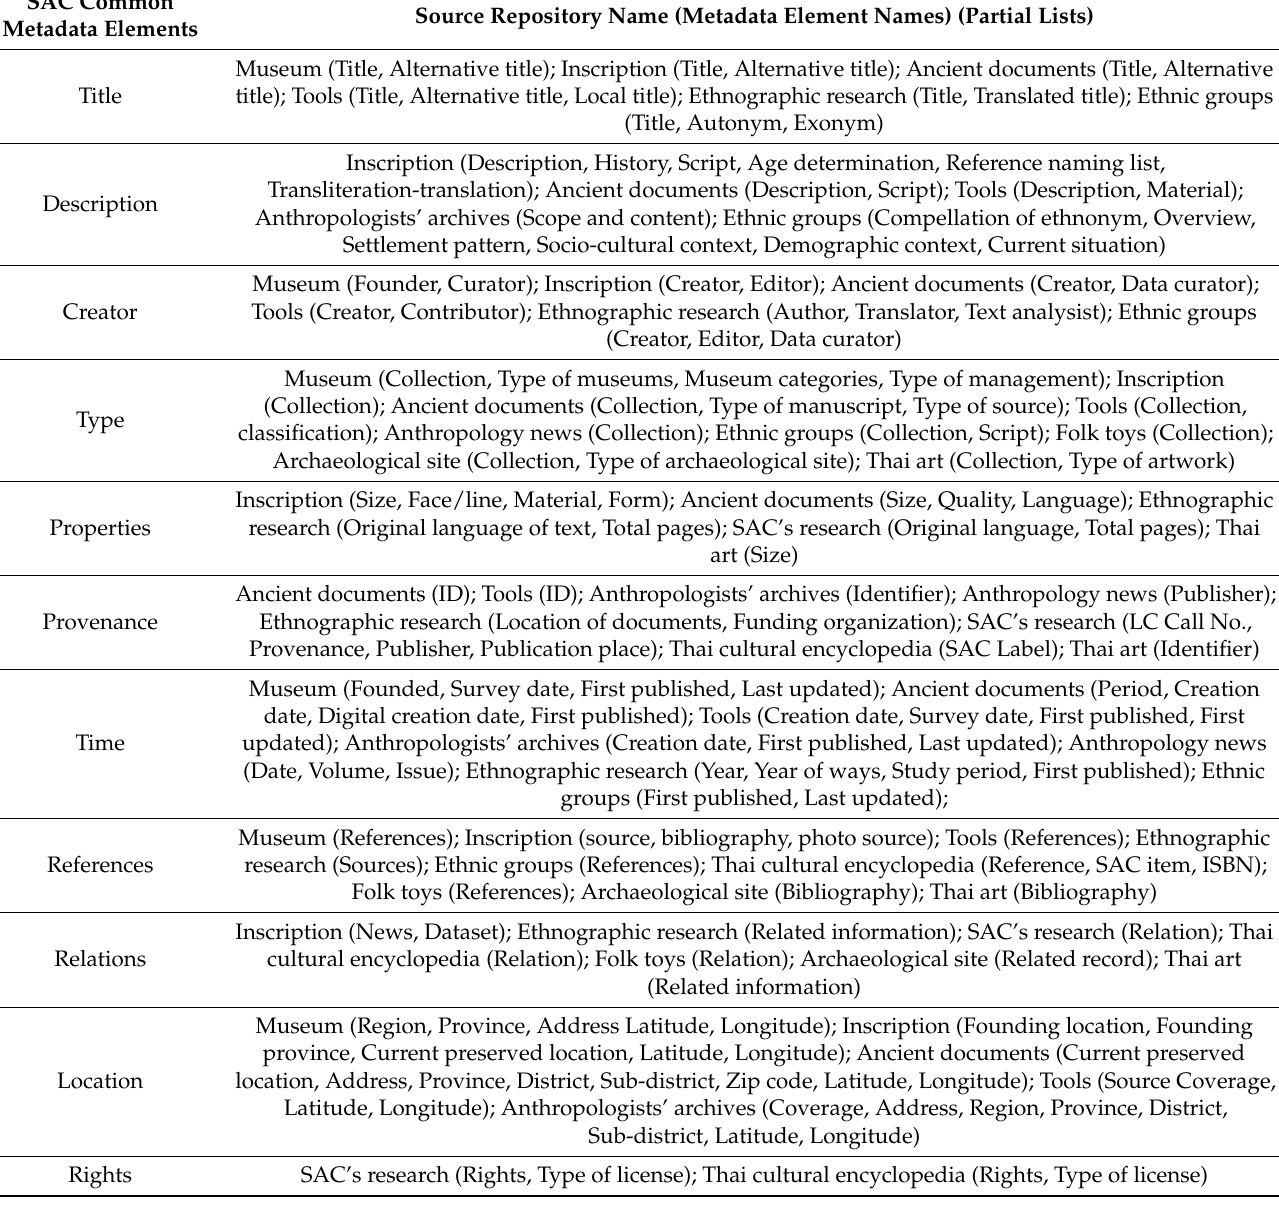
Table 3. Metadata element mapping between source digital repositories and SAC common meta- data